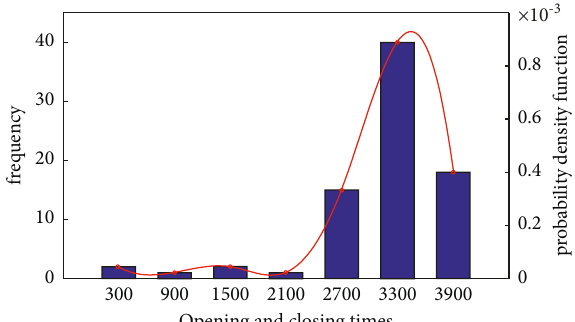
Figure 2: Probability density curve of failure times.